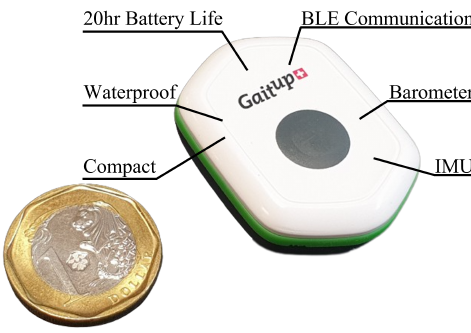
Figure 3. MindMaze Physilog 6 ® (P6)